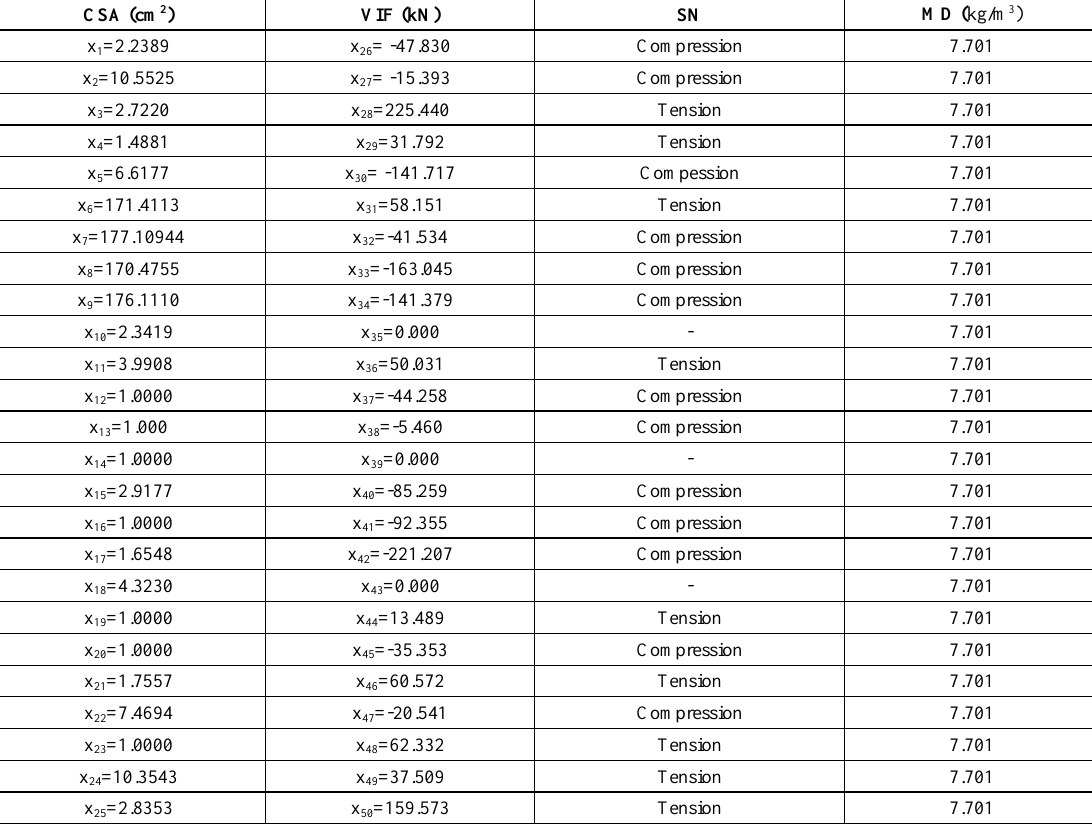
) for the loading case i 1≤i≤25